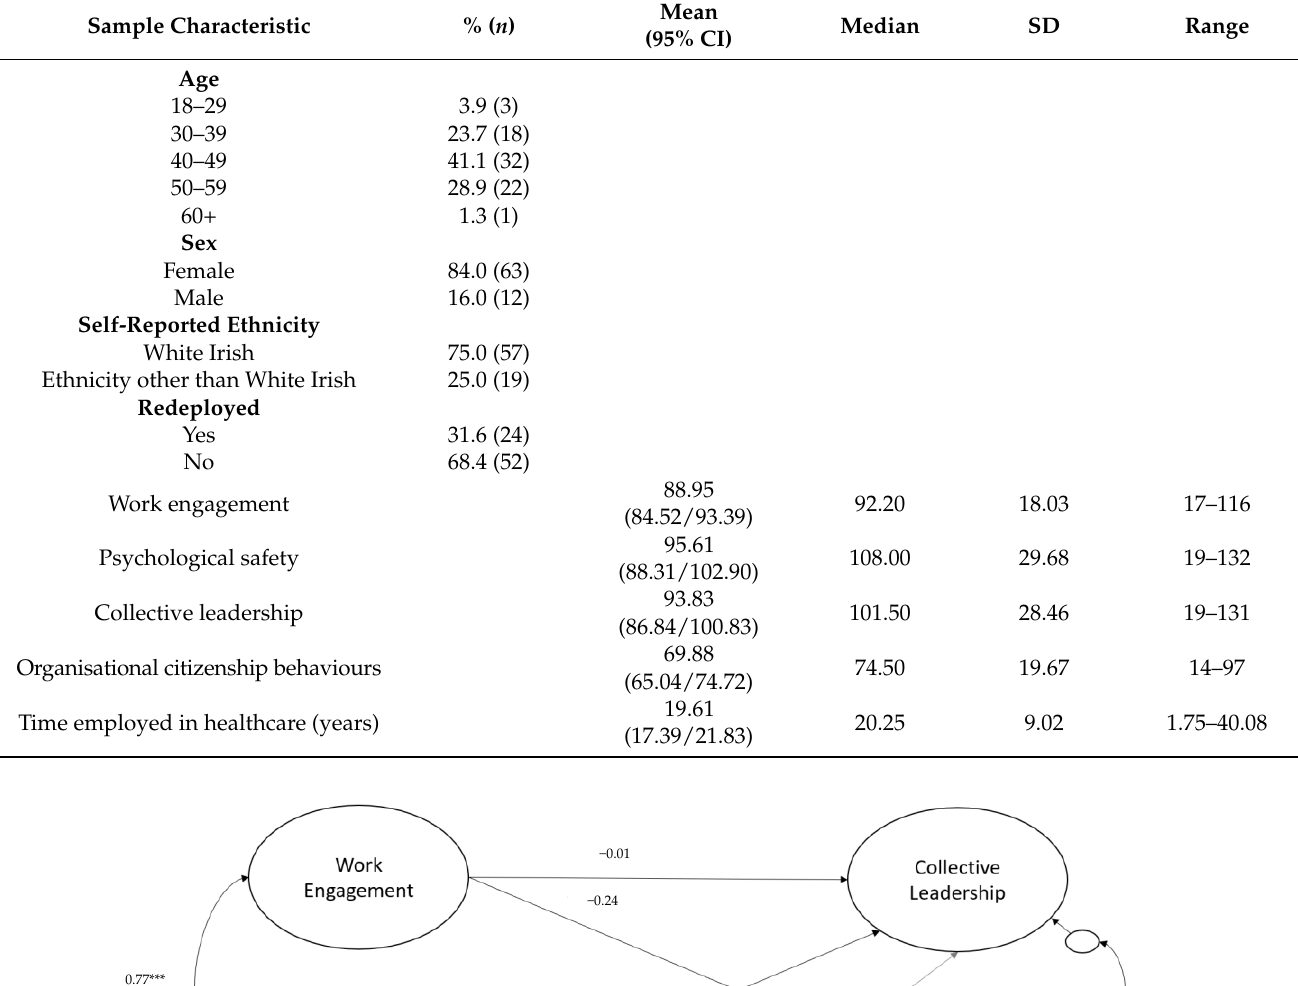
Table 1. Sample characteristics and descriptive statistics of the current study.